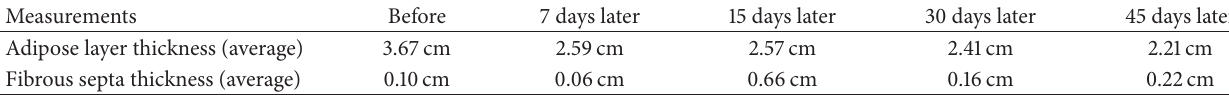
Table 2: Thickness measurement of the fat layer and fibrous septa based on ultrasound data.